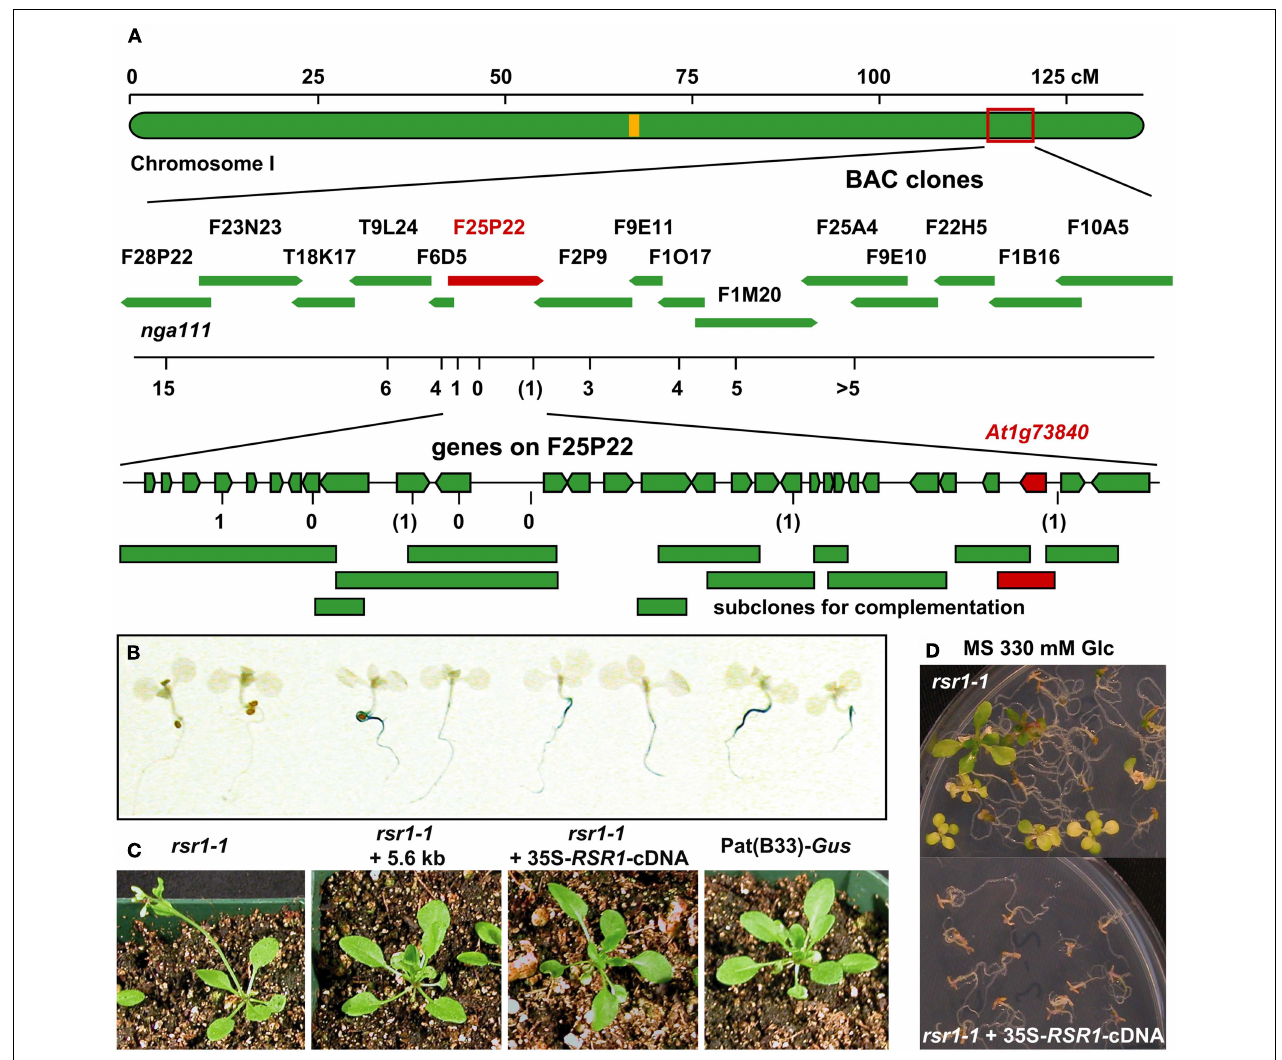
the respective marker was observed. Green bars below BAC F25P22 indicate genomic fragments that could not complement rsr1-1 .The single complementing fragment in which At1g73840 is the only intact gene is shown in red. (B) GUS-staining in roots of seedlings grown in the presence of 90mM sucrose demonstrated that sugar induction of the patatin class II promoter was lost in rsr1-1 plants, but restored by transformation with either the 5.6-kb genomic fragment shown above or the cDNA of At1g73840 under control of the CaMV 35S promoter. (C) Normal flowering was restored in rsr1-1 plants expressing a wildtype copy of At1g73840 . (D) Overexpression of the At1g73840 cDNA in rsr1-1 reverted the gin